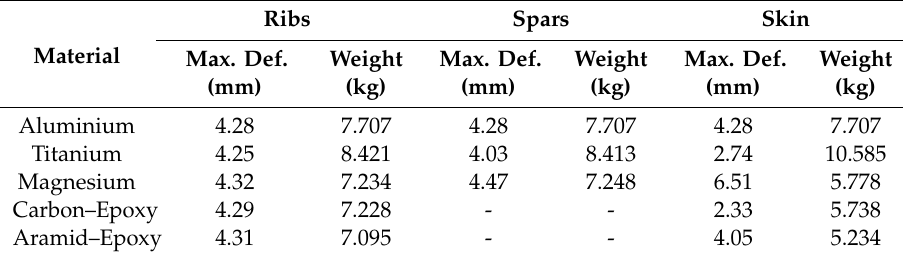
Table 7. Weight and maximum deformation of the wing according to the materials employed. Material